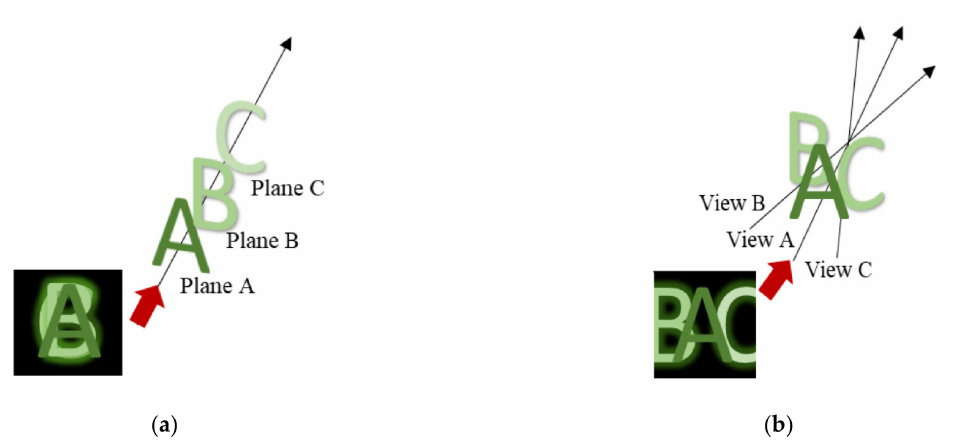
Figure 3. Crosstalk in holographic display in ( a ) multi-depth and ( b ) multi-view.